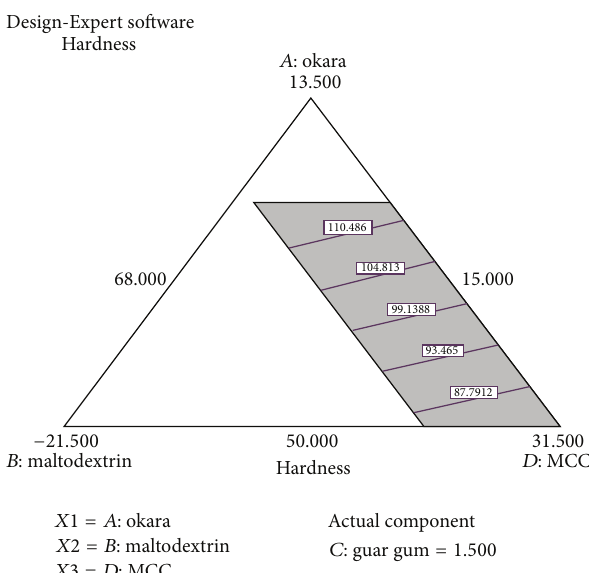
Figure 1: Contour diagram of relationship between three variables, ( 𝐴 ) percentage of okara, ( 𝐵 ) percentage of maltodextrin, and ( 𝐷 ) percentage of Avicel PH-101, and with actual component of guar gum ( 𝐶 = 1.50 %) to the hardness of the tablet.